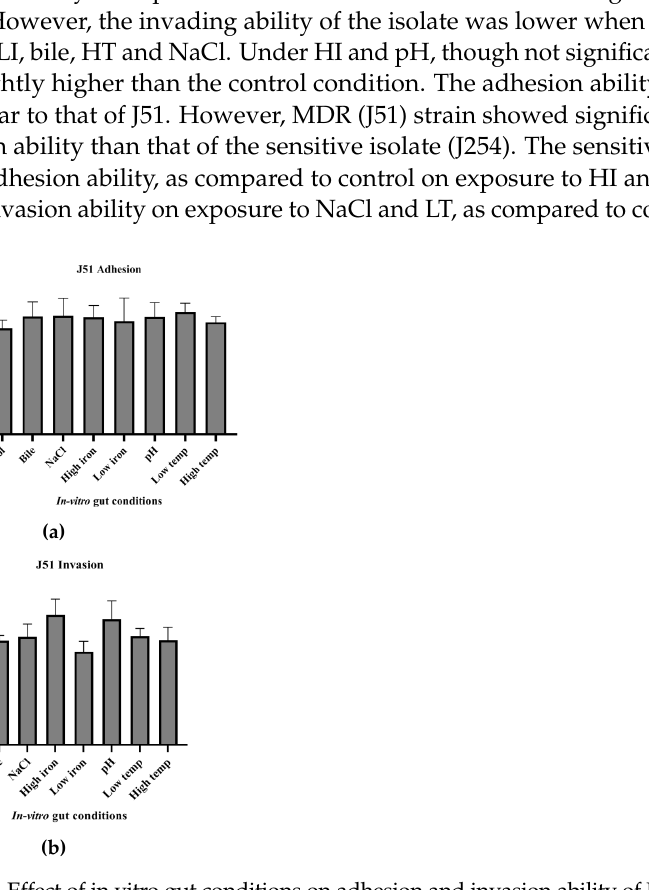
< 0.05) higher invasion ability than that of the sensitive isolate (J254). The sensitive isolate J254 showed better adhesion ability, as compared to control on exposure to HI and pH,